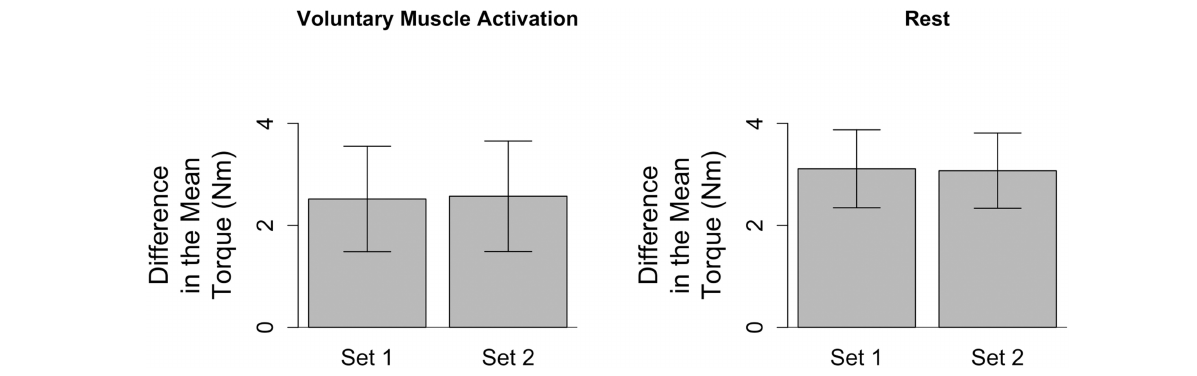
FIGURE 2 | Difference in the mean torque, a proxy for the passive musculoskeletal stiffness, across each session. Mean (bar height) and lower and upper 95th percentile confidence intervals (error bars) are identified for participants’ difference in the mean torque during each slow stretching set (Set 1 and Set 2) of every session (voluntary muscle activation and